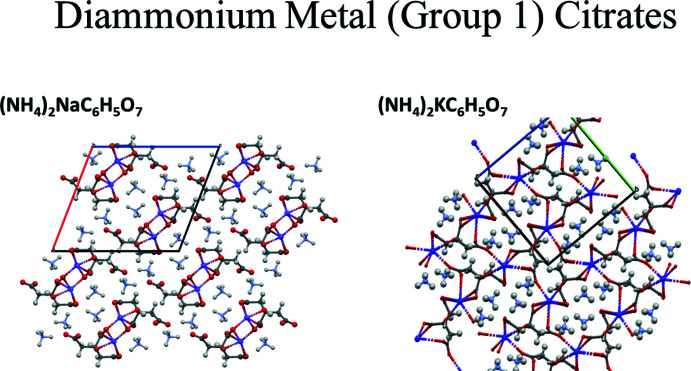
Comparison of the crystal structures of (II) and (NH4)2KC6H5O7.